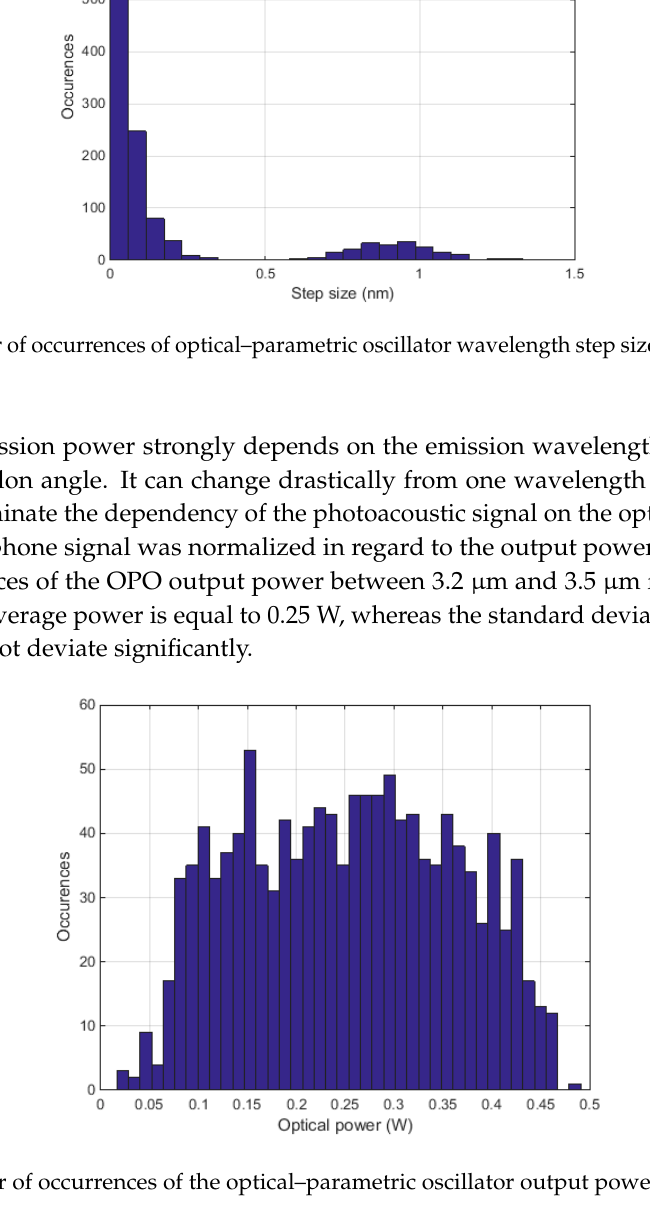
Figure 2. Number of occurrences of optical–parametric oscillator wavelength step sizes between 3.2 µm and 3.5 µm.